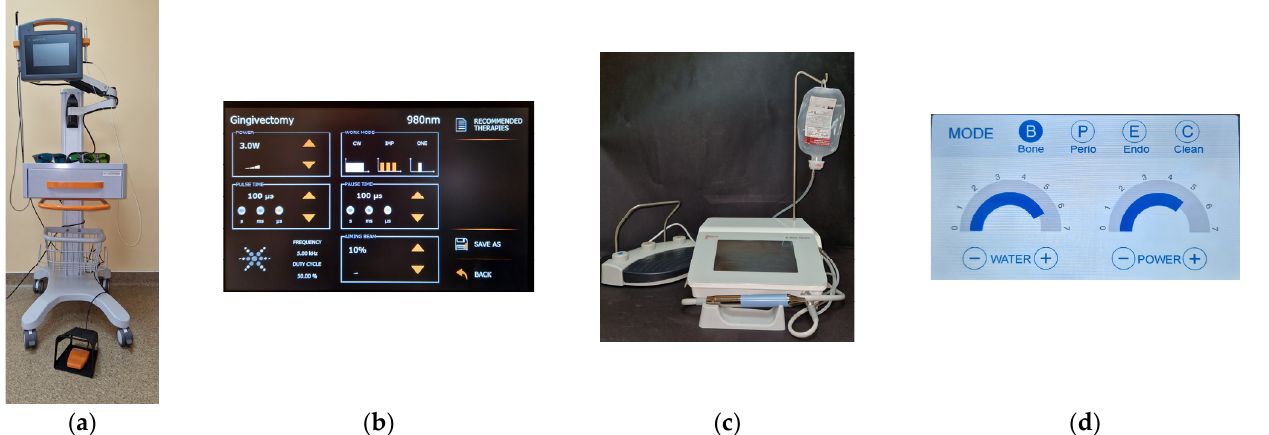
Figure 4. The used devices and the settings: ( a ) Lasotronix Smart M Pro laser; ( b ) The setting of the laser device for the gingivectomy; ( c ) Ultrasurgery III LED piezo-surgery device; ( d ) The setting of the piezo-surgery device.